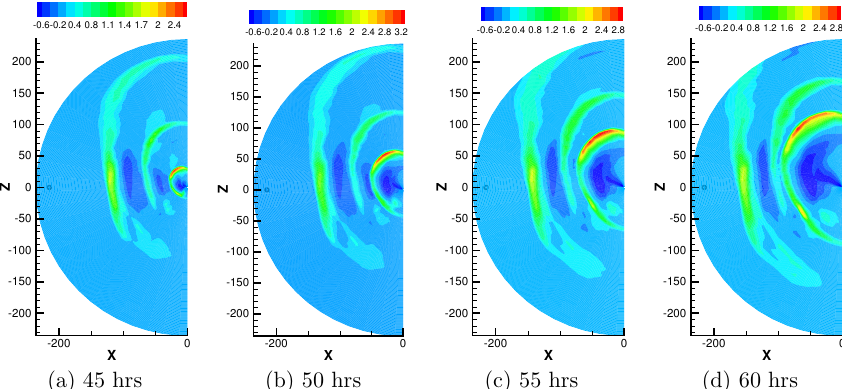
Figure 10. The contour plots of the relative density distribution on the solar-terrestrial meridional plane after ( a ) 45 h ( b ) 50 h ( c ) 55 h and ( d ) 60 h.